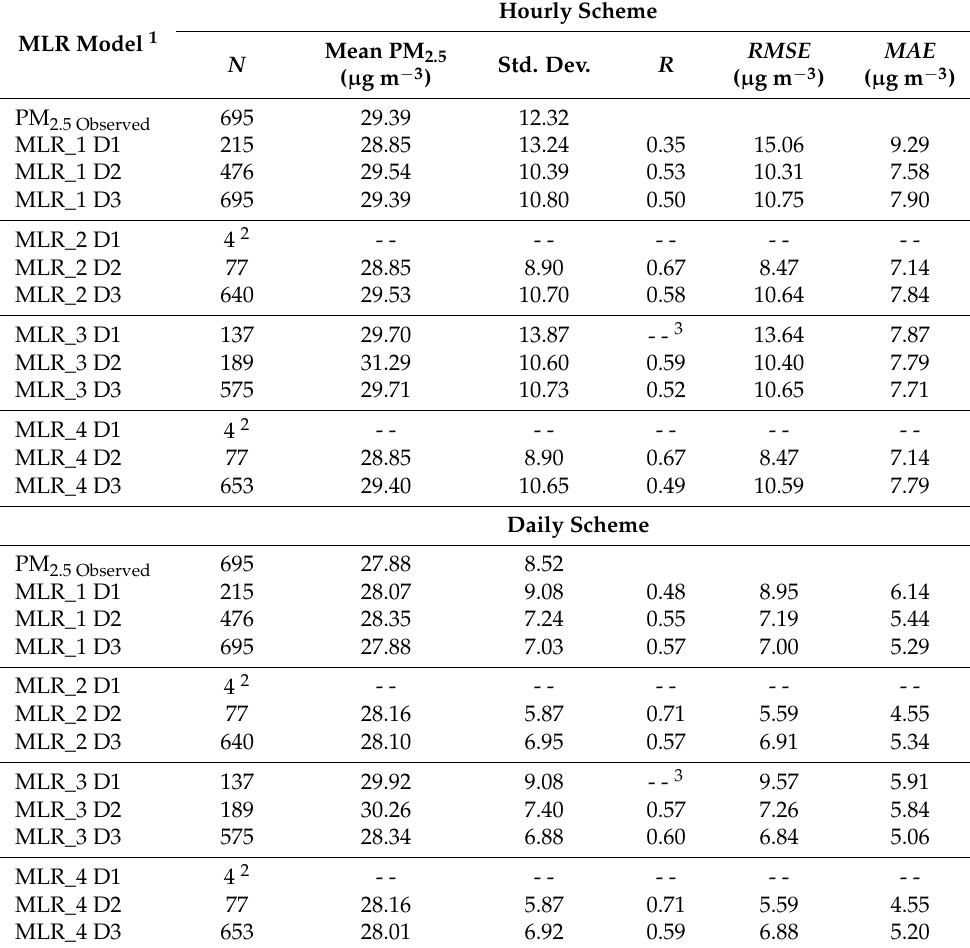
Table 3. Multiple linear regression (MLR) model performance (based on model fitting) for different spatiotemporal averaging schemes, where RMSE is the root mean square error and MAE is the mean absolute